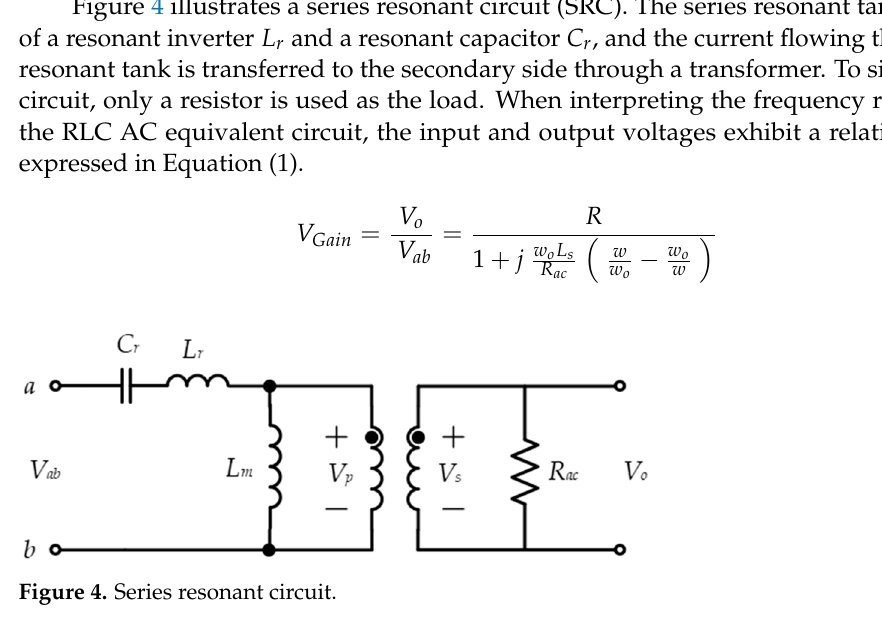
(3) Figure 5. Voltage gain and frequency response characteristics of a series resonant converter. Generally, in resonant converters, the switching frequency 𝑓 (cid:3046) of the power semicon- ductor devices is set higher than the resonant frequency 𝑓 (cid:3045) of the resonant circuit, and the power semiconductor devices are always operated with zero-voltage switching (ZVS) to improve the e ffi ciency of the converter. In the SRC, the output voltage can be controlled using the frequency ratio between 𝑓 (cid:3046) and 𝑓 (cid:3045) ; as the frequency ratio approaches 1, the out- put increases, and vice versa. Therefore, the switching frequency of the power semicon- ductor devices can be varied to control the converter output. However, under no-load or light-load conditions, the output cannot be controlled, and the following challenge exists: the input impedance of the resonant circuit becomes extremely low under a load short- circuit condition. Moreover, as the resonant circuit and the load are connected in series, almost no current fl ows through the resonant circuit under no-load conditions. Therefore, the converter yields an extremely high e ffi ciency under no-load conditions. 2.2. Full-Bridge Series Resonant Converter Full-bridge converters are power electronic circuits widely used in DC-to-DC power conversion, voltage regulation, and energy storage systems. They are applied to various applications, such as electric vehicles, renewable energy systems, and industrial power